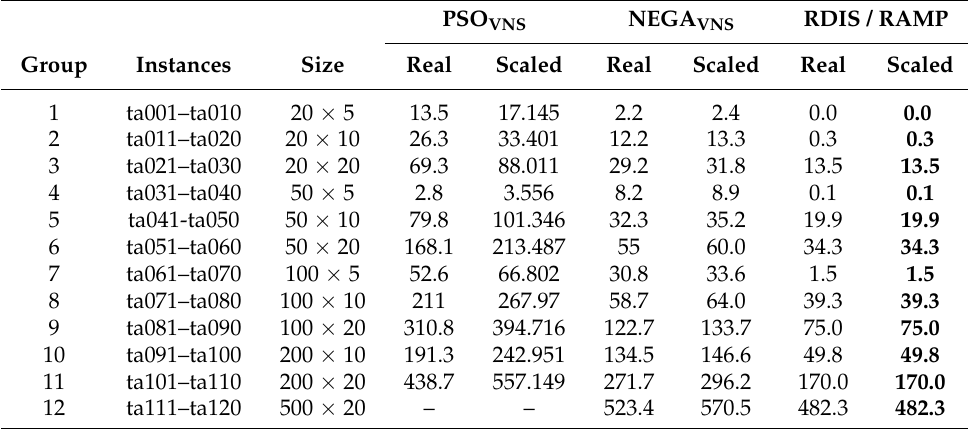
Table 4. Comparison of average time needed to reach the best solution for PSO VNS , NEGA VNS , RAMP, and